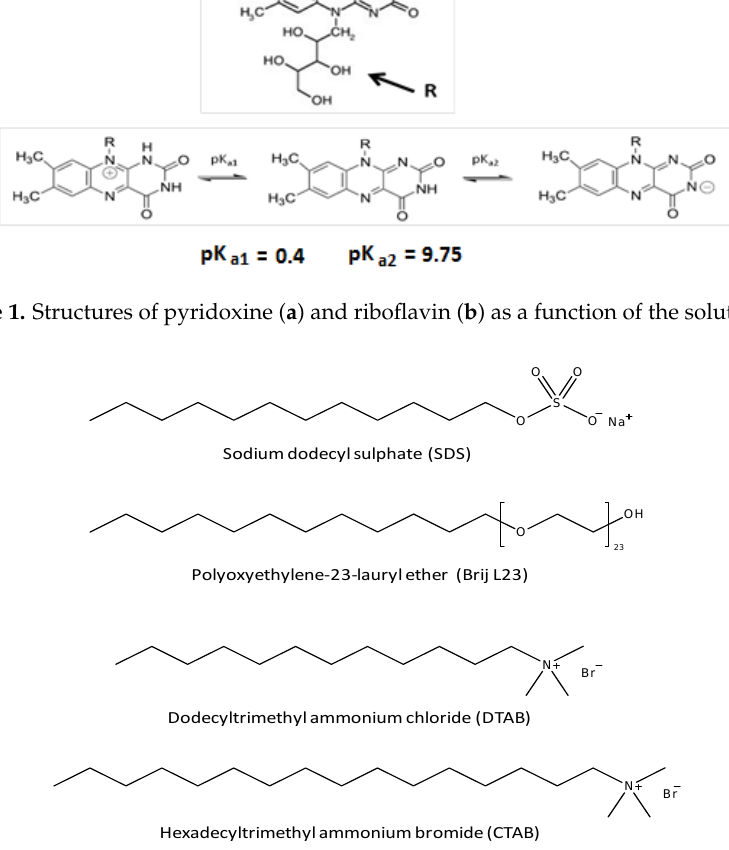
Scheme 2. Structure of the surfactants used for the preparation of graphene (G) dispersions.